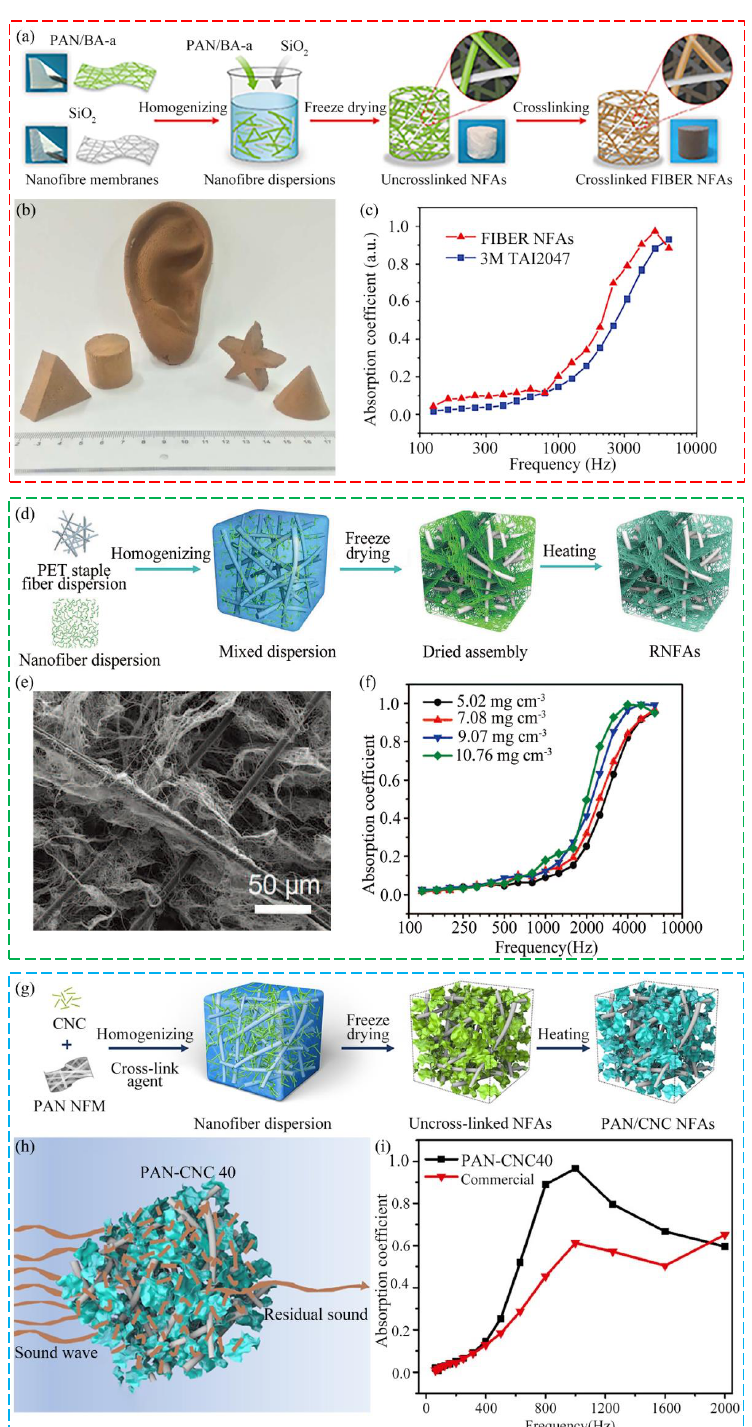
Figure 6. Several nanofiber aerogels for sound absorption. ( a ) Synthetic steps of FIBER NFAs; ( b ) Photographs of FIBER NFAs with several shapes; ( c ) Sound absorption coefficients of FIBER NFAs and commercial 3M TAI2047 nonwovens. Reprinted with permission from ref. [90]. Copyright 2014 Springer Nature. ( d ) Fabrication process of RNFAs; ( e ) Microstructure of RNFAs; ( f ) Sound absorption coefficient of RNFAs with different densities. Reprinted with permission from ref. [91]. Copyright 2019 Royal Society of Chemistry. ( g ) Fabrication of NFAs; ( h ) Sound absorption mechanism of PAN-CNC40; ( i ) Sound absorption coefficients of the PAN-CNC40 and the commercial fibrous sound absorption felt. Reprinted with permission from ref. [38]. Copyright 2021 Elsevier.